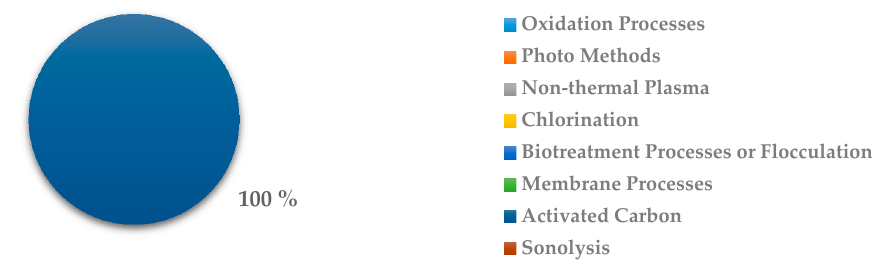
Figure 32. Percentage of scientific articles worldwide regarding wastewater treatments of alimentary tract and metabolism drugs between 1998 and 2020. Data collected in Scopus database by using wastewater or water as keywords and English as a language limitation.